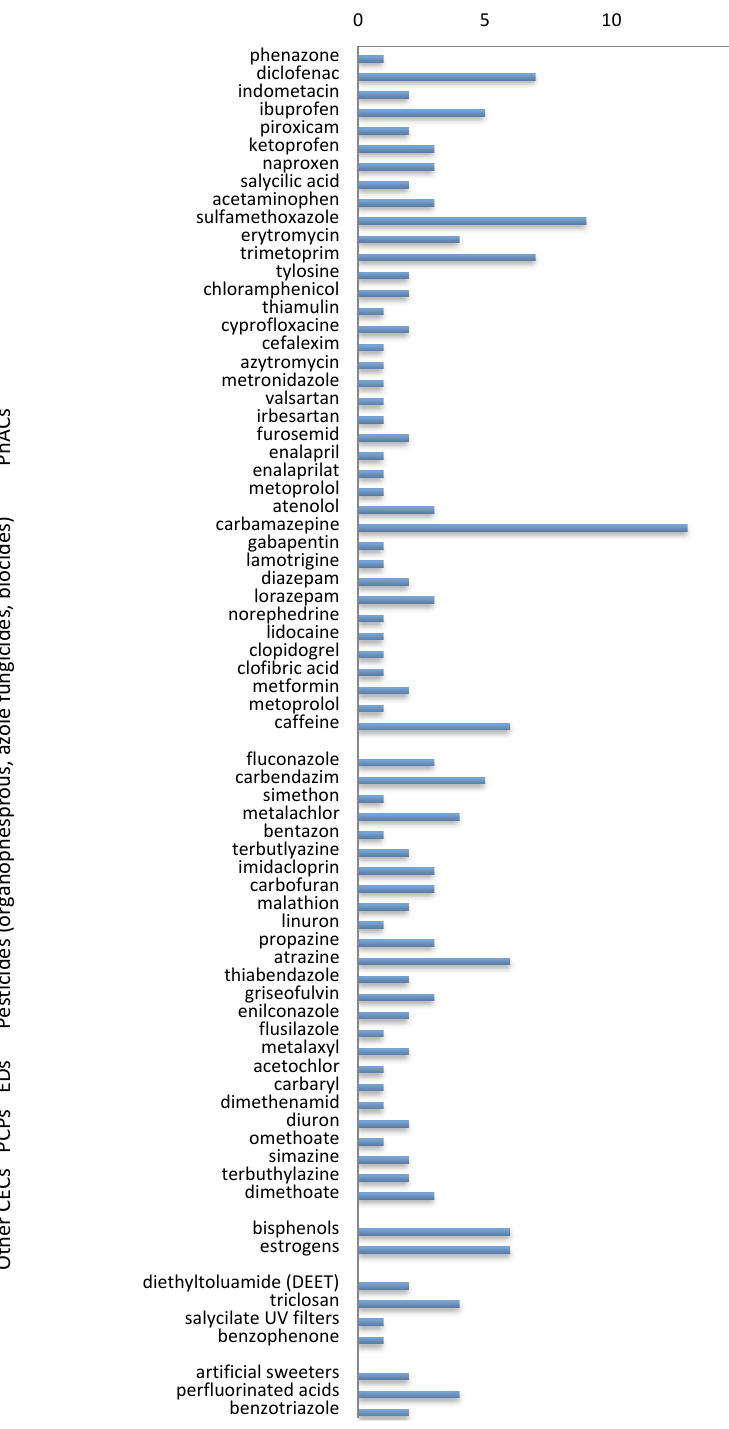
Figure 5. Frequency of the detection of certain CECs reported in the monitoring campaigns on Lower Danube and North-Western Black Sea basins, published between 2010 and 2021.